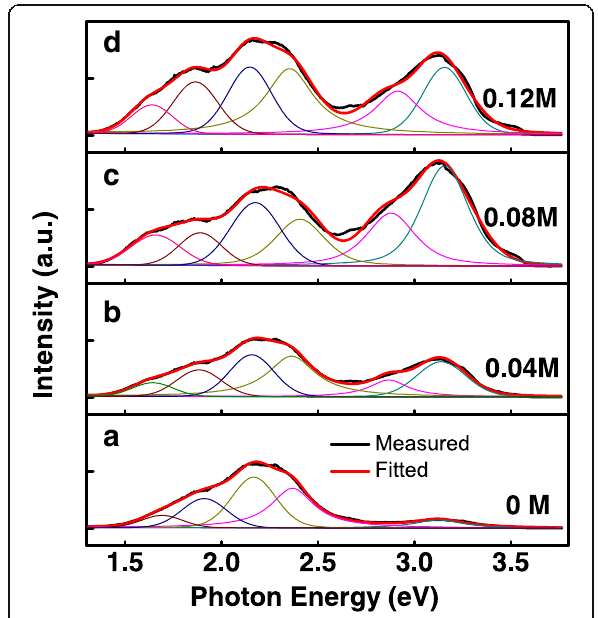
Fig. 6 Peak fitting of PL spectra of four samples, a 0 M ZnO, b 0.04 M AZO, c 0.08 M AZO, and d 0.12 M AZO